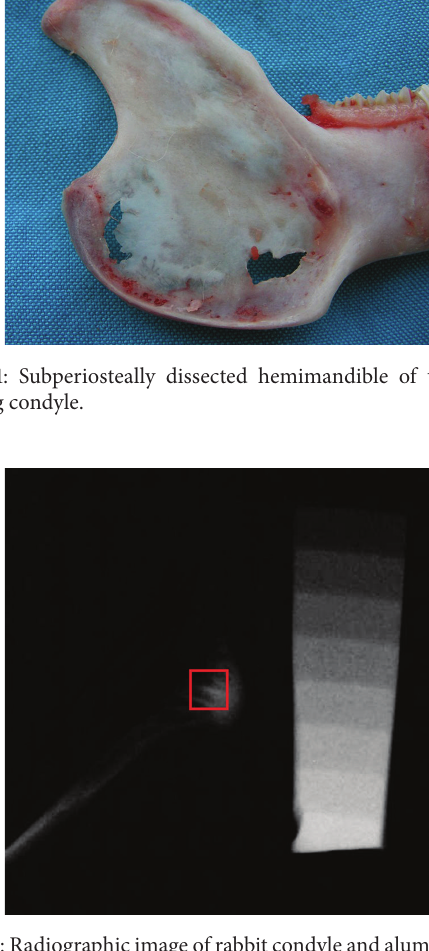
Figure 2: Radiographic image of rabbit condyle and aluminum step wedge from control